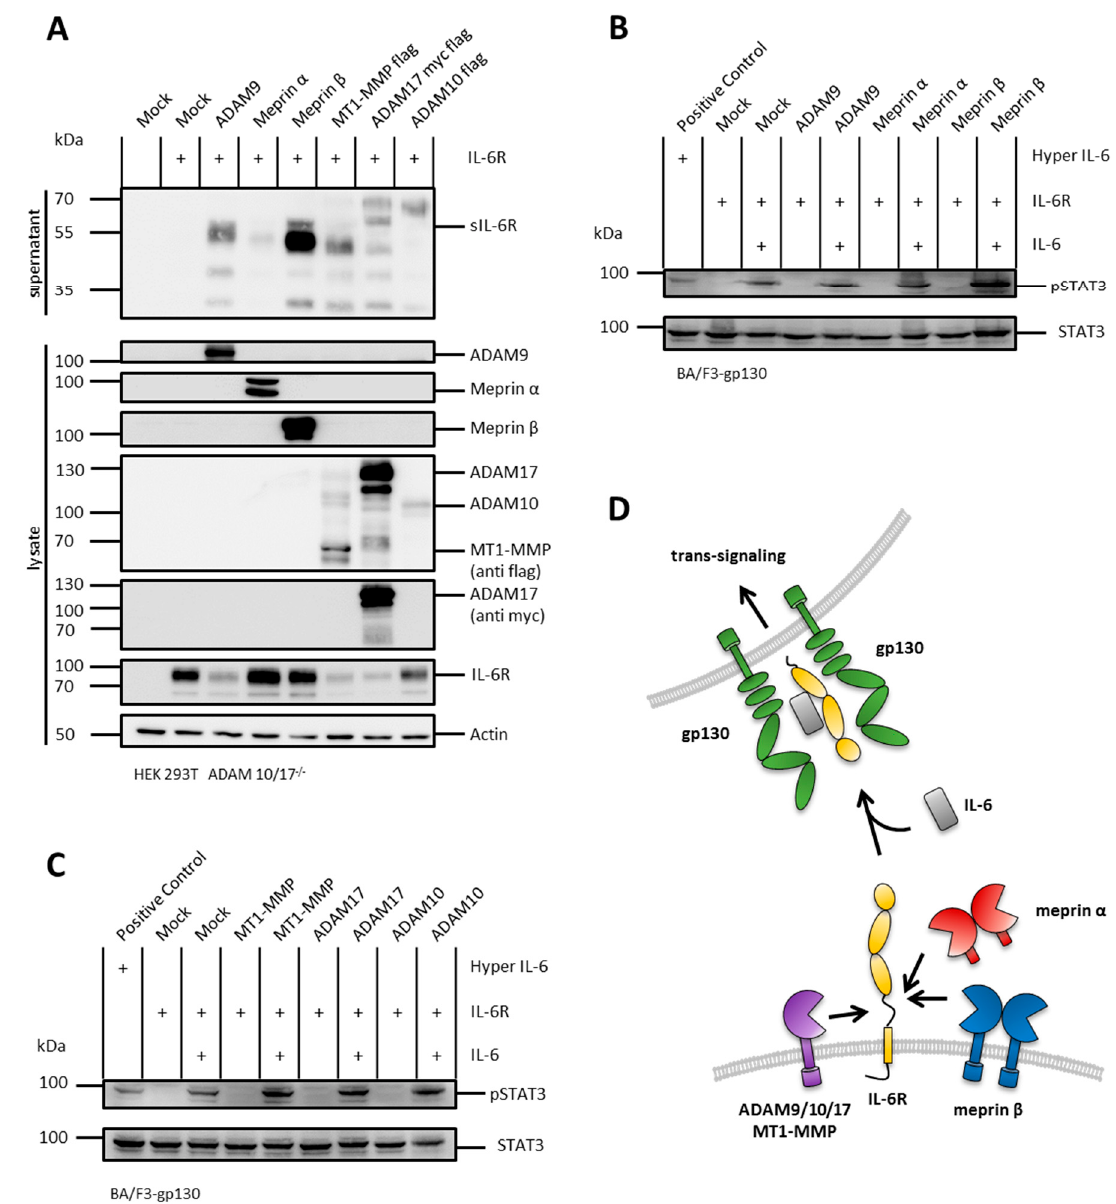
Figure 4. The IL-6R is shed by di ff erent metalloproteases and induces IL-6 trans-signaling. ( A ) HEK293T ADAM10 / 17 − / − cells were transfected with IL-6R and / or ADAM9, meprin α , meprin β , MT1-MMP, ADAM17, or ADAM10. Supernatants were ultracentrifuged, TCA-precipitated, and analyzed by immunoblotting with an antibody raised against the D1-domain of the IL-6R. ADAM9, meprin α , and meprin β were detected with specific antibodies in lysate controls. MT1-MMP and ADAM10 are flag-tagged and ADAM17 flag- / myc-tagged and detected respectively in lysate controls. pcDNA3.1 served as mock and actin as loading control. ( B ) Phosphorylation of STAT3 in Ba / F3-gp130 cells stably transfected with gp130. Cells were treated with supernatants from the experiments in ( A ) and with recombinant IL-6. Phosphorylation of STAT3 was analyzed for cotransfection with ADAM9, meprin α , and meprin β . A fusion protein consisting of soluble IL-6R and IL-6 (Hyper IL-6) served as positive control. Mock control from ( A ) served as negative control. Phosphorylation was detected with an antibody raised against phosphorylated STAT3. Total STAT3 protein served as loading control. ( C ) Same experimental setting as in ( B ) but for MT1-MMP, ADAM17, and ADAM10 as IL-6R sheddases. ( D ) Schematic overview of IL-6R shedding by ADAM9, ADAM10, ADAM17, MT1-MMP, meprin α , and meprin β .